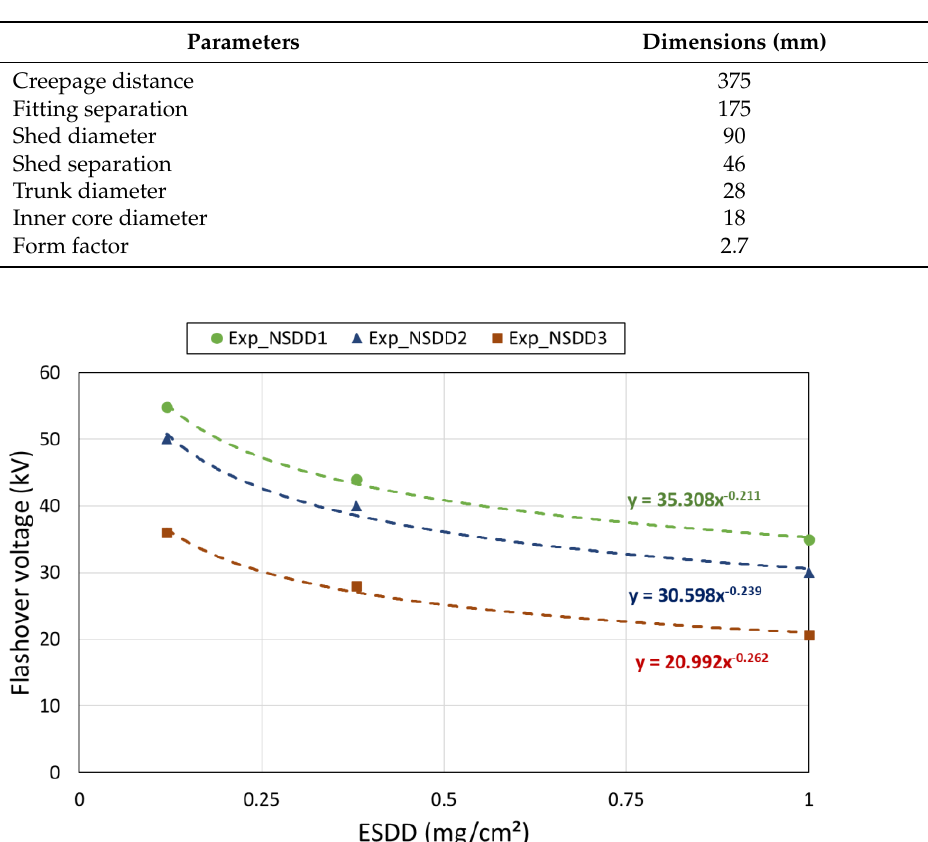
Figure 2. Variation of average flashover voltage vs. ESDD for different NSDD levels.